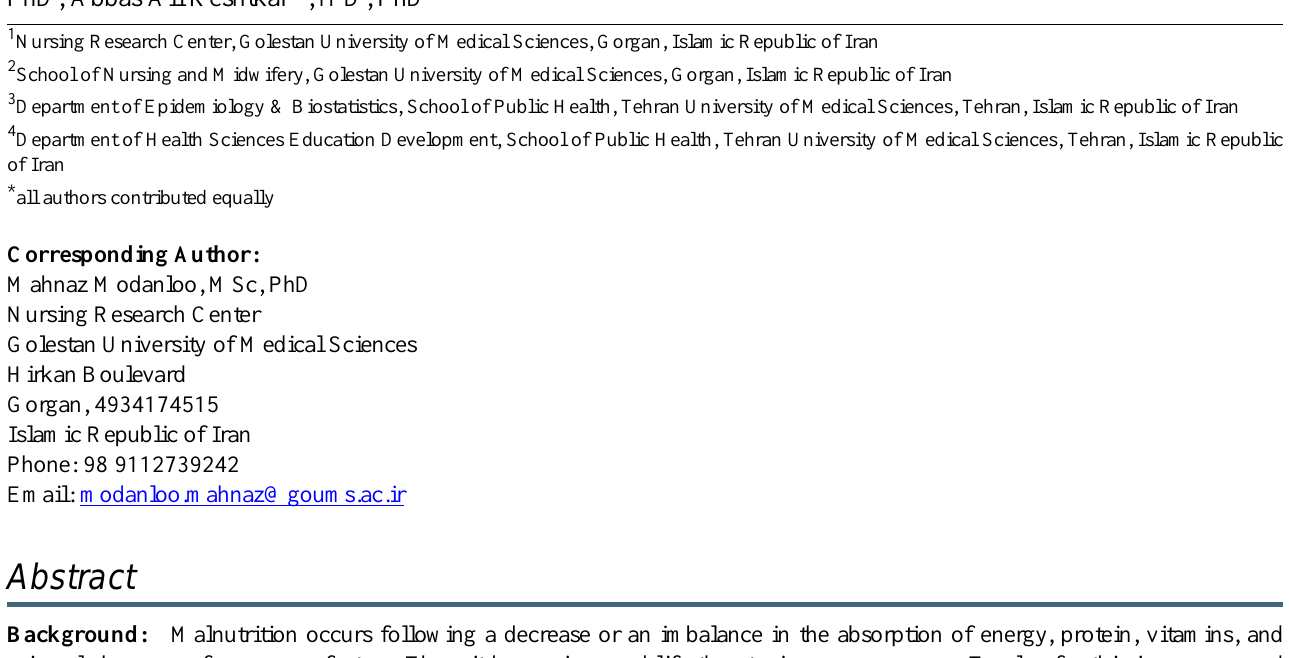
malnutrition; systematic review; aged; prevalence;